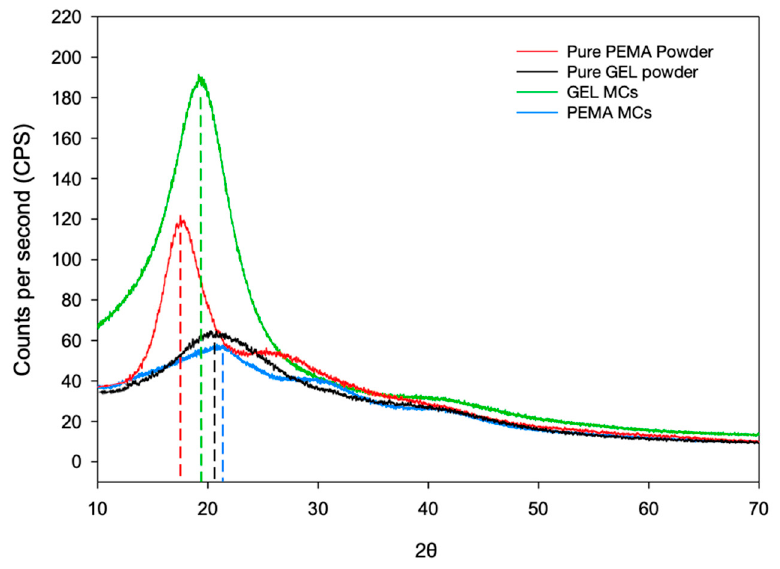
Figure 8. XRD scans for pure PEMA powder, the pure GEL powder, and the microcapsules produced with PEMA and GEL as the emulsifier.